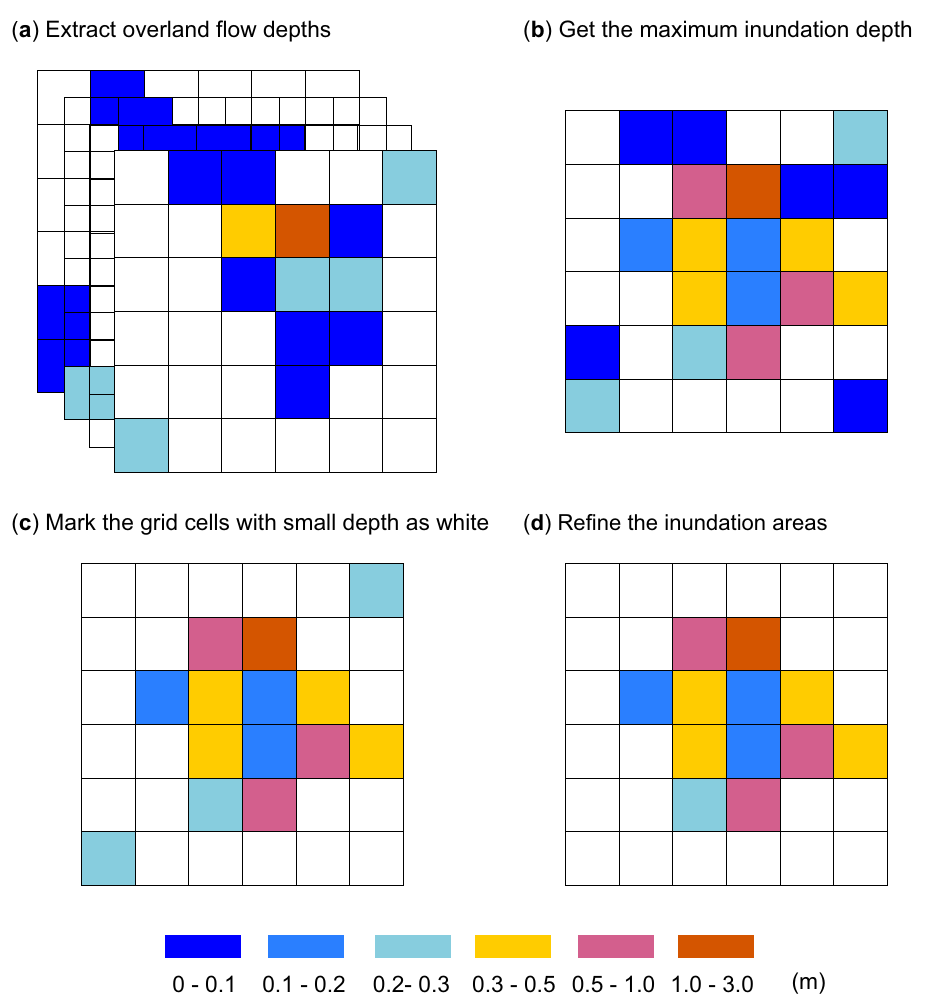
Figure 7. Method of obtaining the inundation areas from the calculated results. ( a ) Collect the calculated overland flow depths with a one-hour interval during the examination periods. ( b ) Compare and obtain the maximum inundation depth in each cell. ( c ) Mark the cells with the small inundation depth (0.1 m) as white. ( d ) Refine the inundation areas to ignore the areas where the number of connected cells is smaller than